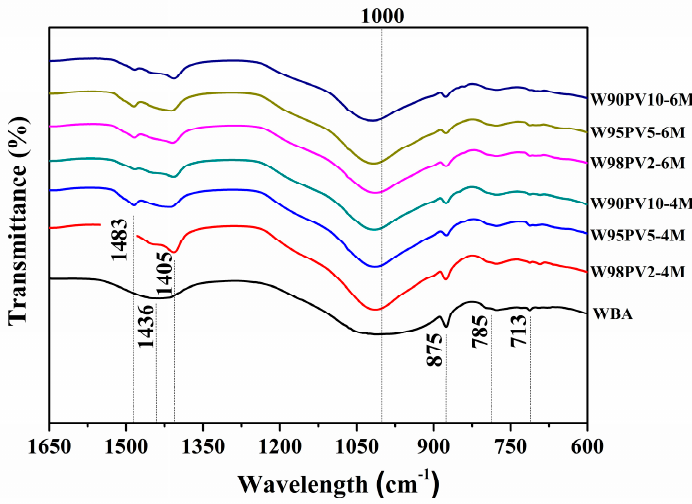
Figure 5. FT-IR spectra of WBA and AA-WBA/PV. The deconvoluted FT-IR spectra in the range of 1200–800 cm − 1 are shown in Figure 6. The W98PV2-4M and W90PV10-6M samples were selected as they had the lowest and highest NaOH concentration and aluminium content, respectively. The spectra present the same peaks that have slightly displaced to lower frequencies due to increases in the NaOH concentration and PV content. The main narrow band at 1016–1013 cm − 1 and the band at 1144–1153 cm − 1 are ascribed to the ν 3 (Si-O) bridging bond stretching vibrations [56]. The displacement of these bands to lower frequencies for the W90PV10-6M sample indicates a lower degree of polymerization of the silicate chains [41]. The two bands at ≈ 900 and ≈ 866 cm − 1 correspond to Si-O terminal bonds, indicating an incomplete polymer- ization of the gel [56]. Finally, the narrow peak at 875 cm − 1 corresponds to calcium car- bonate stretching vibrations (C-O).